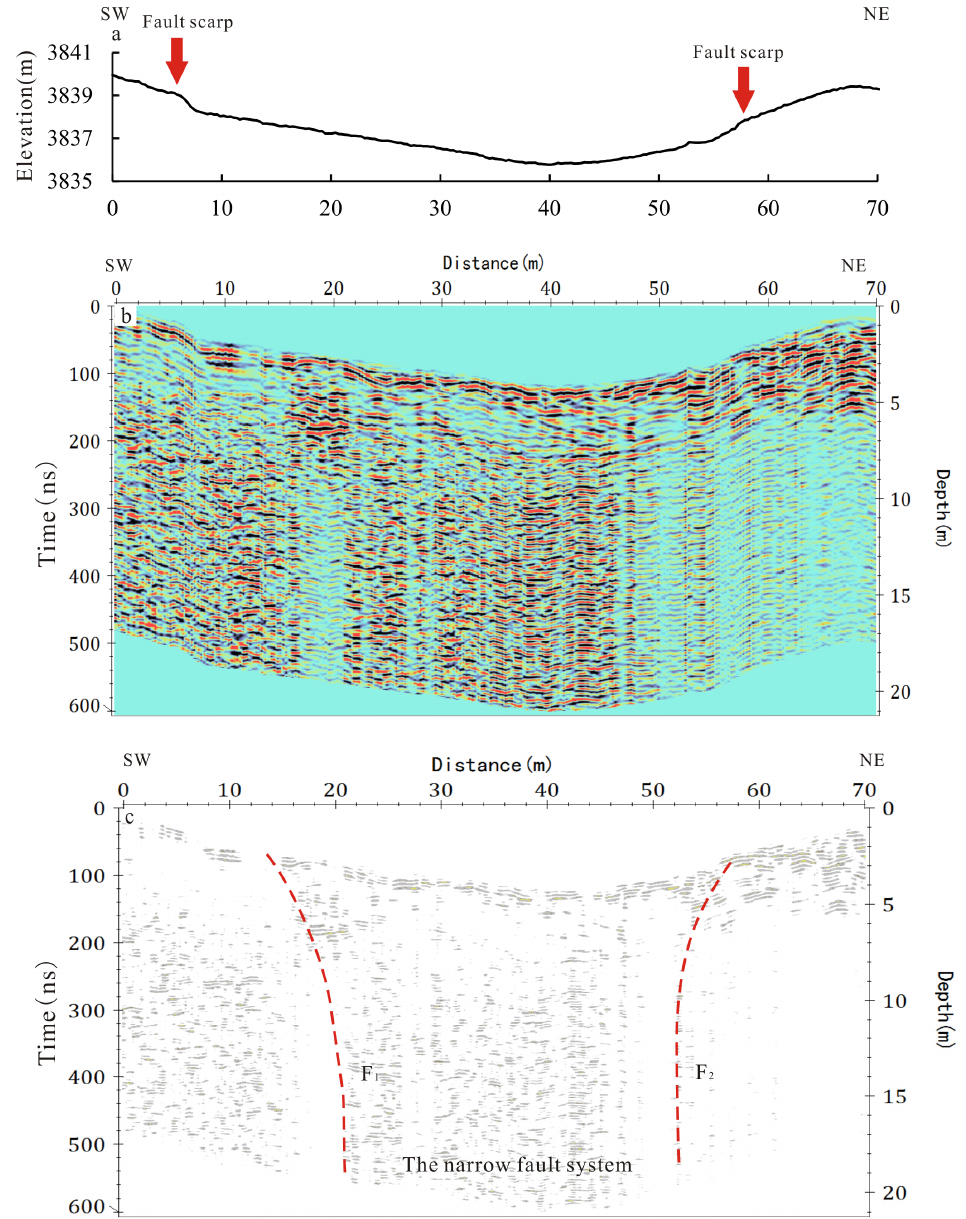
Figure 8. The processed and interpreted 100 MHz GPR profile. ( a ) Topographic profiles of the 100 MHz GPR measuring line (line 2 in the Figure 2b). ( b ) The processed 100 MHz GPR image. ( c ) Conceptual profile of 100 MHz GPR data. Red dotted lines imply the interpreted faults F 1 and F 2